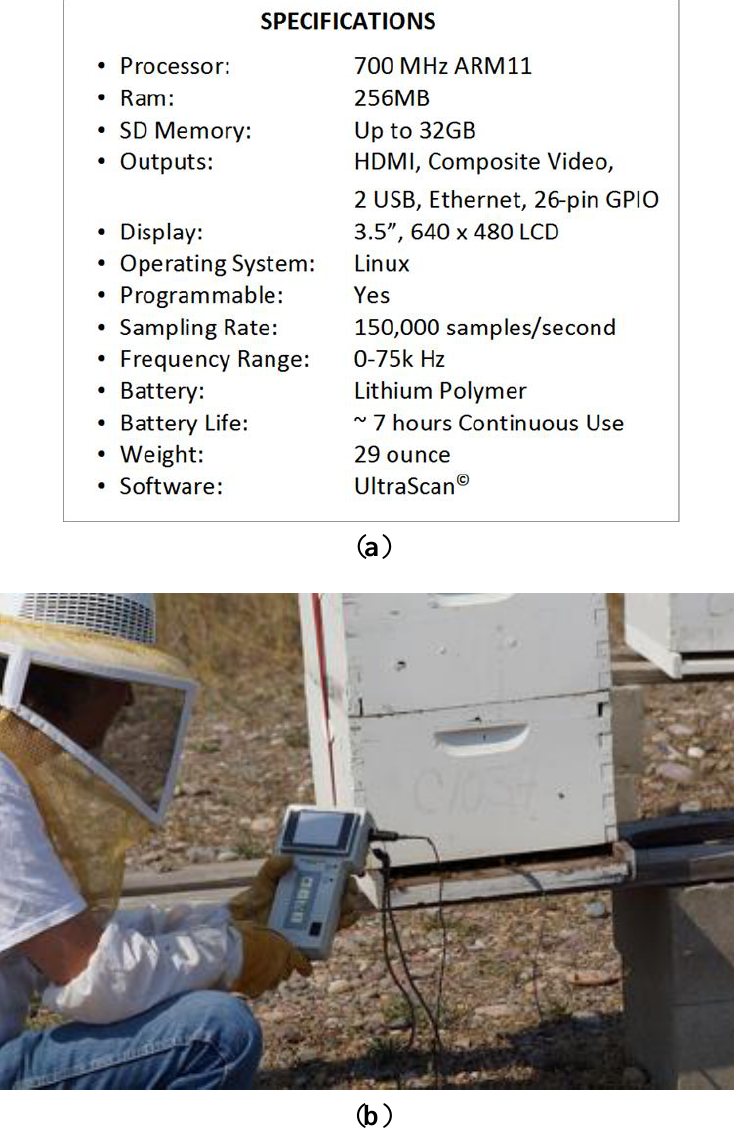
Figure 9. ( a ) Instrument specifications for hand-held acoustic scanner (HAS) for detection of bee pests, diseases, and exposures to harmful chemicals; Bee Alert Technology, Inc., (Missoula, Montana, USA); ( b ) HAS acoustic scanner. A probe microphone is slid into the colony entrance and a 60 s recording taken. The device reads out the detections and probability of detection (e.g., queenless, 95% probability; varroa mites, 28% probability; Africanized bees, 97%, and so